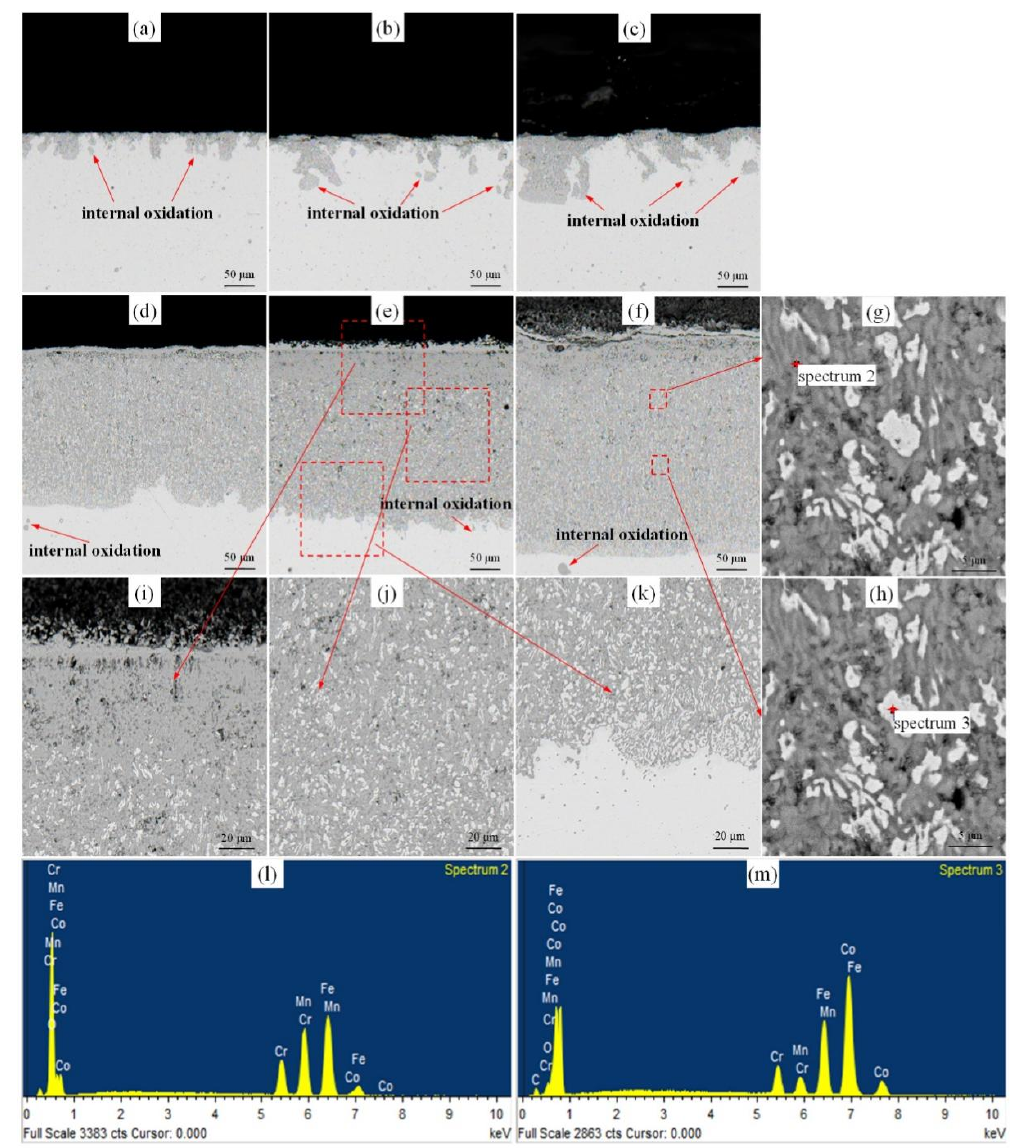
Figure 5. Cross-section images of Cr-Mn-Fe-Co HEA after oxidation test at 700 °C for ( a ) 12 h, ( b ) 24 h, ( c ) 48 h, and at 900 °C for ( d ) 12 h, ( e ) 24 h, ( f ) 48 h. ( g , h ) for one magnification image of ( f ), ( i – k ) three magnified images of ( e ), ( l ) the element distribution of spectrum 2, ( m ) the element distribution of spectrum 3.